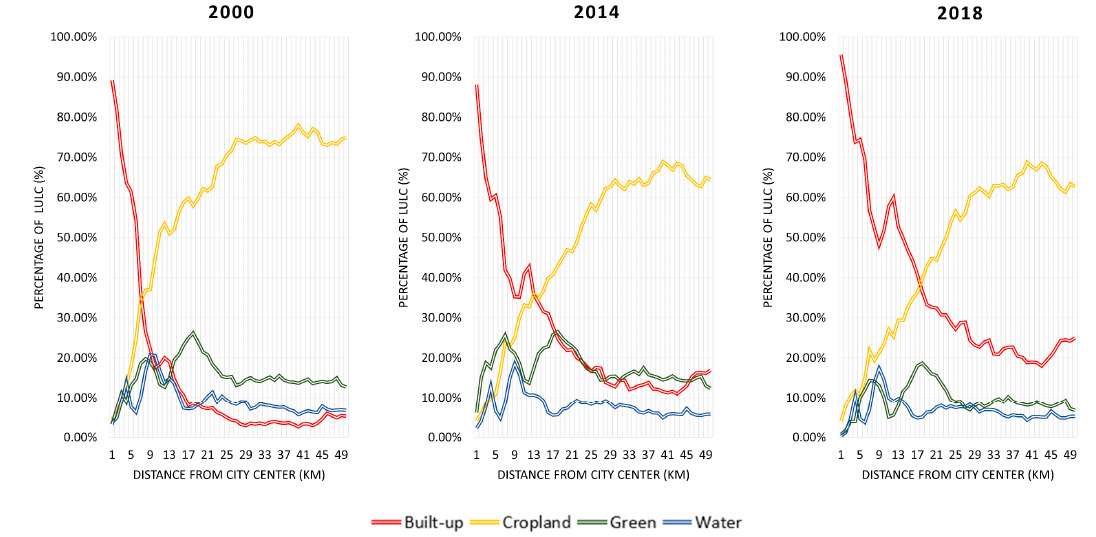
Figure 4. Urban-rural gradient analysis of Nanjing in 2000, 2014, and 2018.